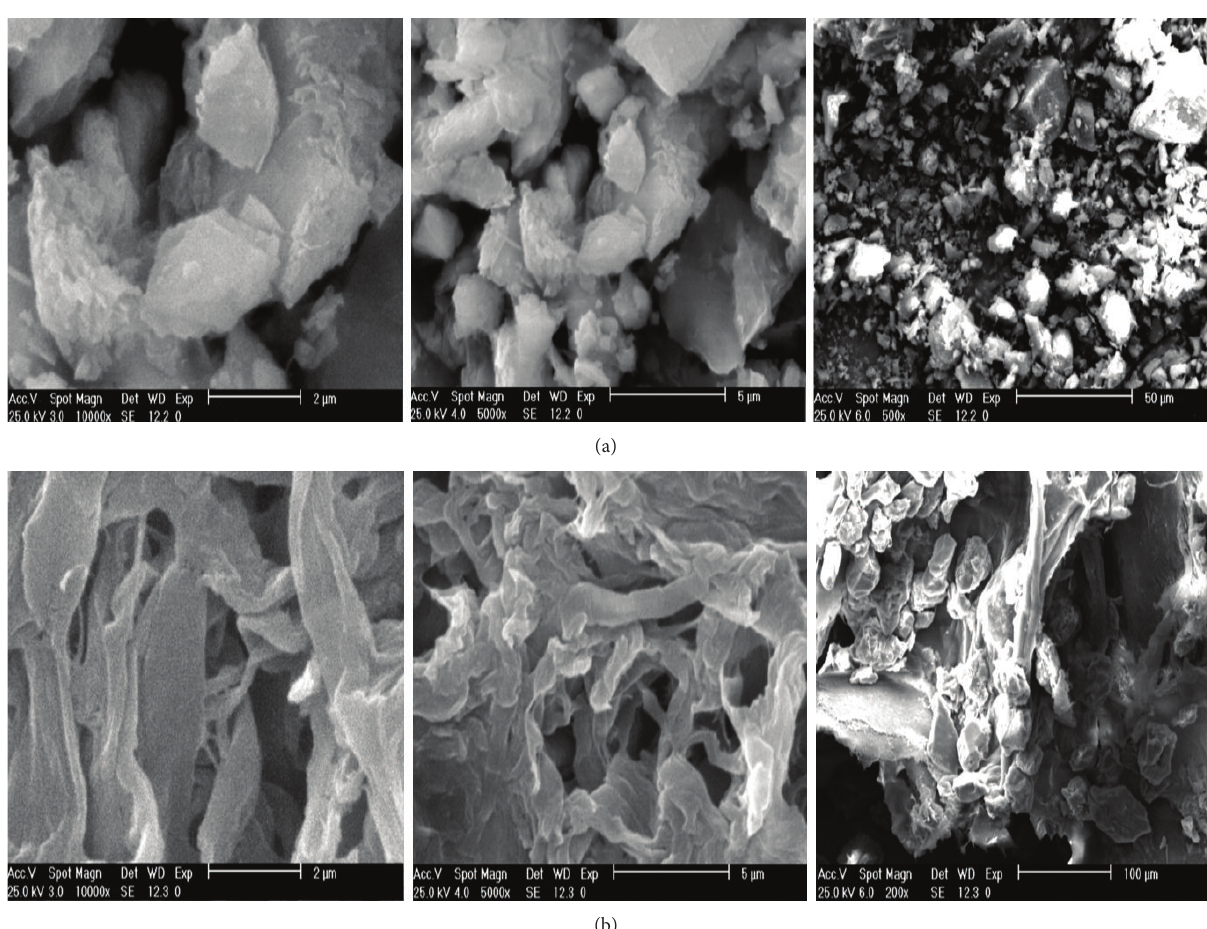
Figure 3: SEM images of raw feldspar (a) and CTS/feldspar biobased composite